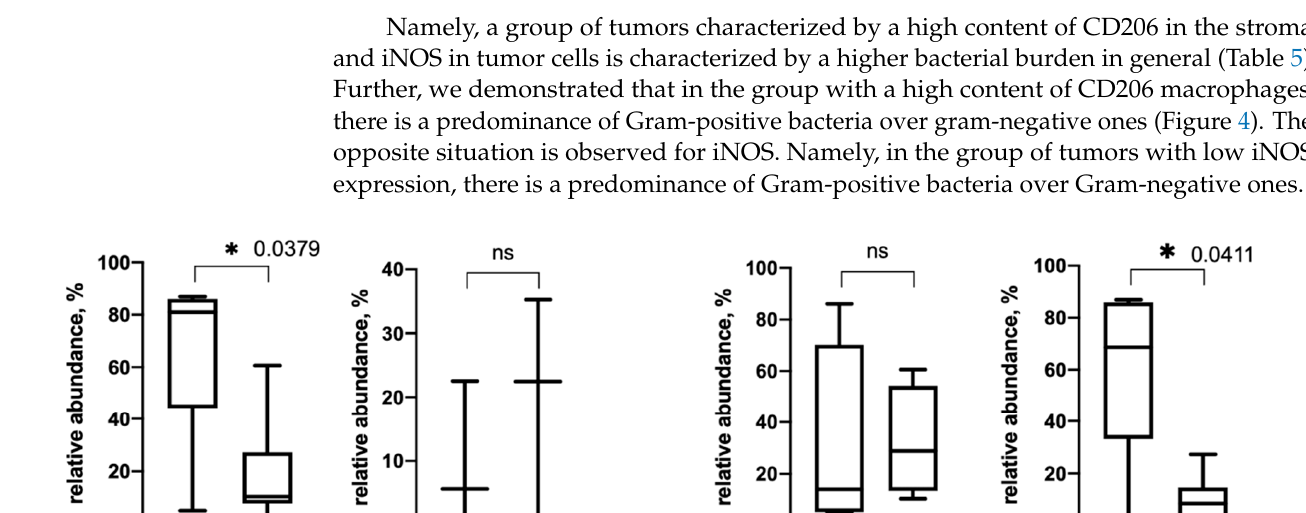
Figure 5. Survival of patients with ESCC versus total bacterial burden ( A ), Gram-negative bacterial burden ( B ) and Gram- positive bacterial burden ( C ). The differences were not statistically significant. As can be seen from the graphs presented, the total bacterial burden is not a prog- nostically significant parameter for ESCC. Next, we analyzed the survival rate depending on the total bacterial burden and the phenotype of the tumor stroma. We have previously shown that FoxP3 is a favorable prognostic marker for esophageal cancer [14]. Therefore, we analyzed FoxP3 together with the bacterial burden and found that FoxP3 is a marker of a favorable prognosis in the group of tumors with a high bacterial burden (HR = 0.3534, p = 0.0441) (Supplementary Materials Figure S1). For other analyzed markers, no correla- tions were found between survival and the bacterial burden. Previous analysis revealed a correlation between the CD206 content in tumors and the total bacterial burden [14]. However, the analysis of survival depending on the CD206 content, and the total bacterial burden did not reveal any patterns. We also showed that in tumors characterized by a high content of CD206, Gram-positive bacteria predominate, therefore we analyzed the survival in groups depending on the content of CD206 together with gram+ or gram- microorganisms (Figure 6).